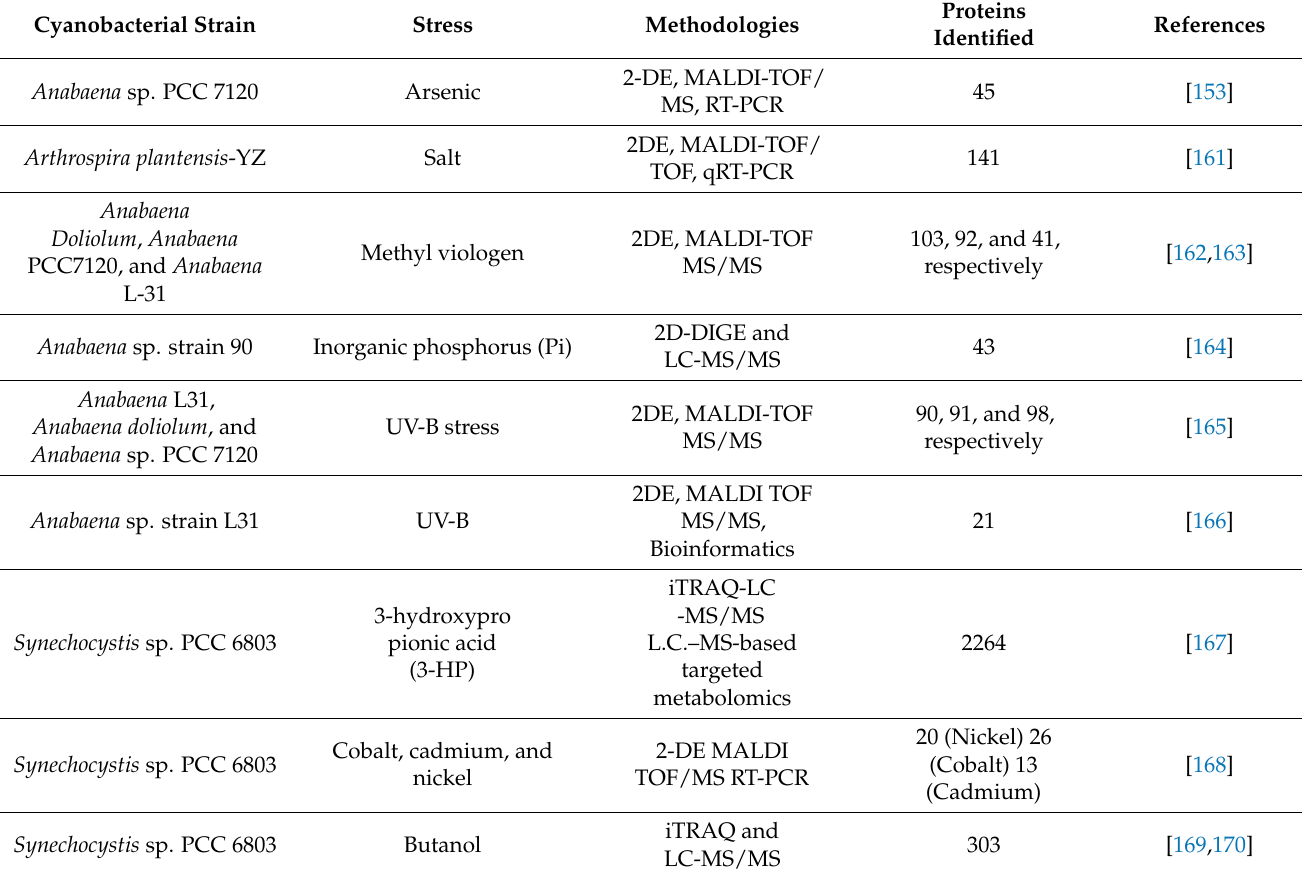
Table 2. Proteome analyses in response to different abiotic stresses in cyanobacteria. Cyanobacterial